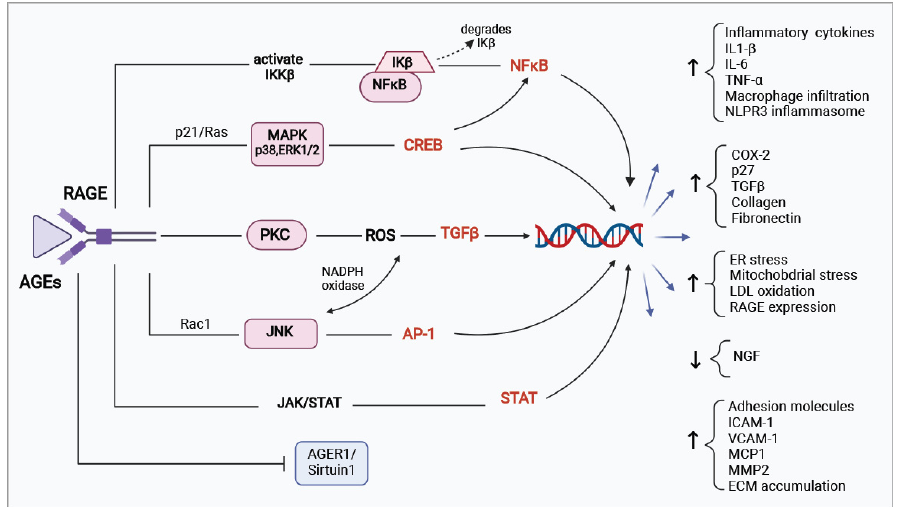
Figure 3. AGEs/RAGE axis and diabetic complications. The AGEs/RAGE interaction triggers several signaling cascades such as IKK/NF- κ B, ERK/MAPK, PKC, JNK and JAK/STAT and activates transcription factors such as NF κ B, CREB, AP-1, and STAT3, which results in oxidative stress and amplifies inflammatory responses. The AGEs/RAGE axis will stimulate macrophage infiltration, increase gene expression of inflammatory cytokines, adhesion molecules, and ECM proteins. It will result in overexpression of TGF- β , fibronectin, and collagen. The increase in ER stress will lead to enhanced oxidative stress which will further cause inflammatory responses and activate LDL oxidation. The RAGE expression will be upregulated in response to positive feedback by AGEs/RAGE axis induced NF κ B activation. The AGEs/RAGE/NF κ B-driven sustained inflammation and oxidative stress activation of signaling cascades play an important role in the pathogenesis of diabetic complications. AGE: advanced glycation end products; IL-1 β : interleukin 1 beta; IL-6: interleukin 6; TNF α : tumor necrosis factor alpha; COX-2: cyclooxygenase-2; p27: cyclin-dependent kinase inhibitor 1B; TGF β : transforming growth factor beta; NGF: nerve growth factor; ICAM-1: endothelial and leukocyte associated transmembrane protein; VCAM-1: vascular cell